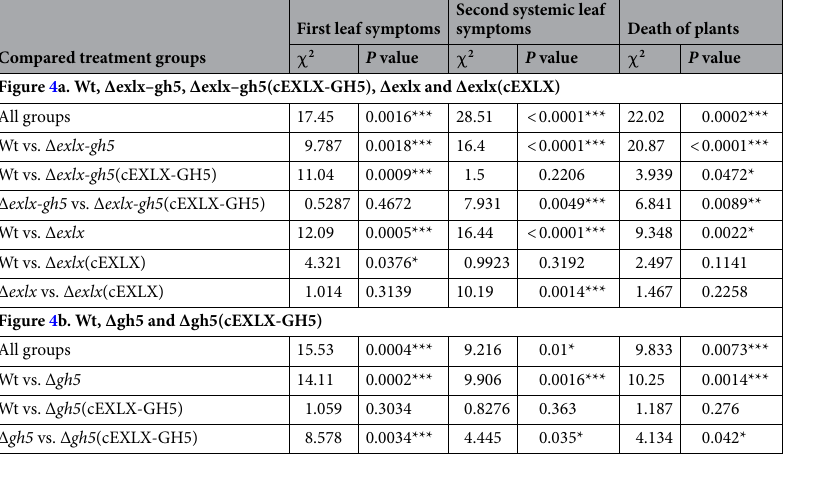
Compared treatment groups Figure 4a. Wt, Δexlx–gh5, Δexlx–gh5(cEXLX-GH5), Δexlx and Δexlx(cEXLX) All groups